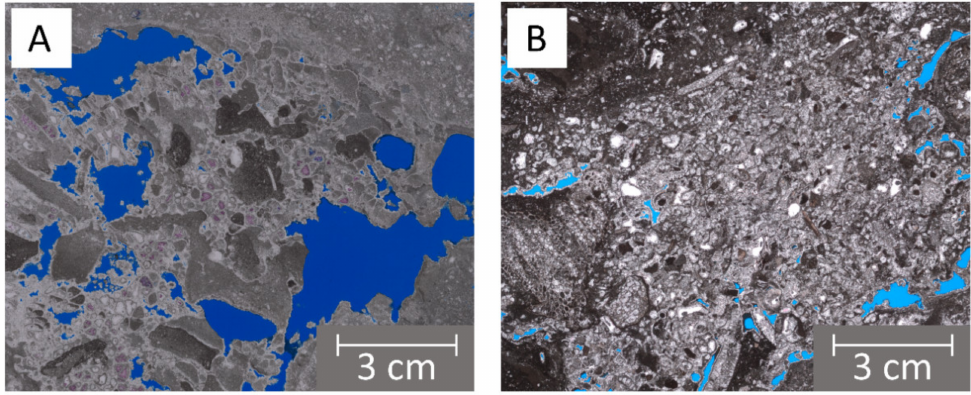
Figure 6. Images showing increase in cementation and decrease in vug size moving from north to south, as shown in Figure 5. Both images are from thin sections collected at 25 m depth from each well. Blue represents porosity. ( A ) Well C9; ( B ) Well